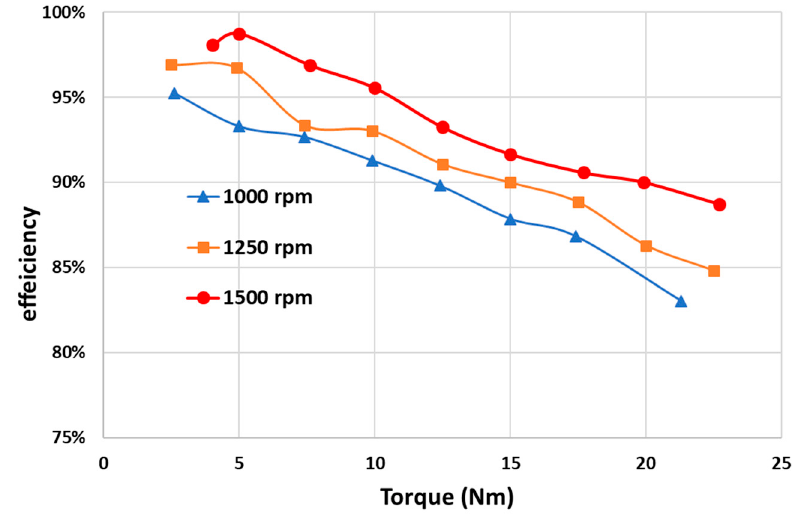
Figure 29. Efficiency curve vs. torque for different rotational speed. The efficiency decreases with the increase in the torque, which corresponds to an increase in the current and thus of the Joule